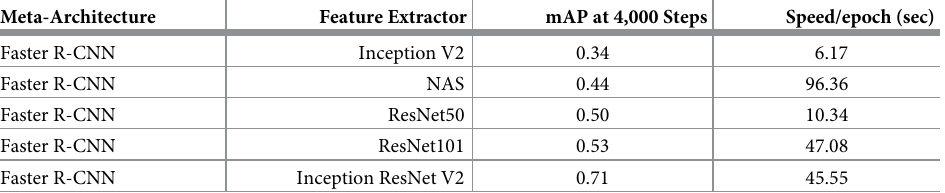
Table 4. Validation performance and training speed for Inception V2, NAS, ResNet50, ResNet101 and Inception ResNet V2 on Faster